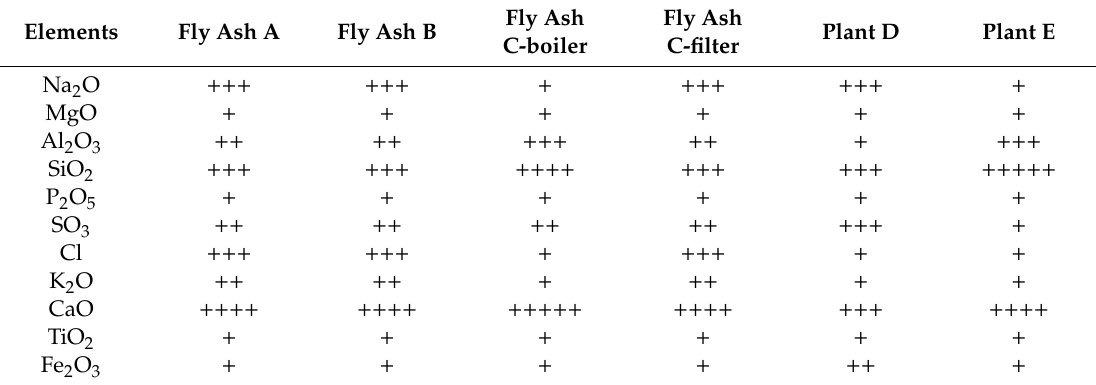
Table 3. Total content of matrix elements in di ff erent fly ash samples determined by XRF.